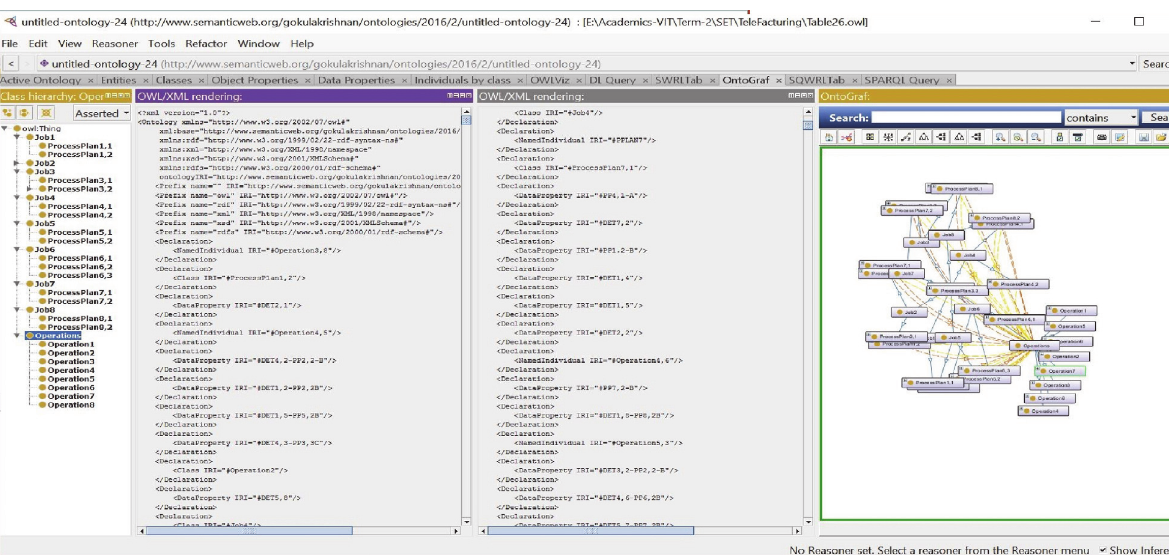
Figure 4: Snapshot of the generated XML